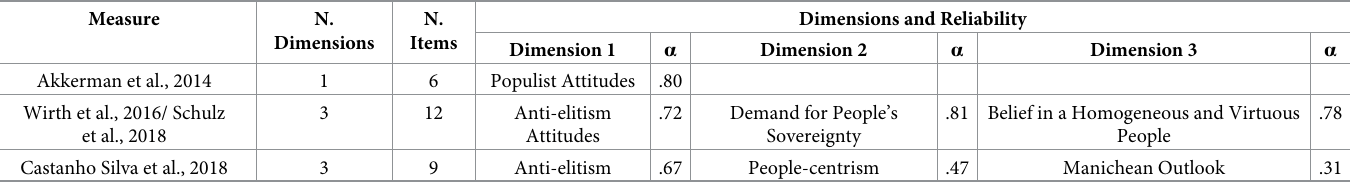
Table 1. Comparative summary of the three measures of adherence to populist ideology. Measure N. N. Dimensions